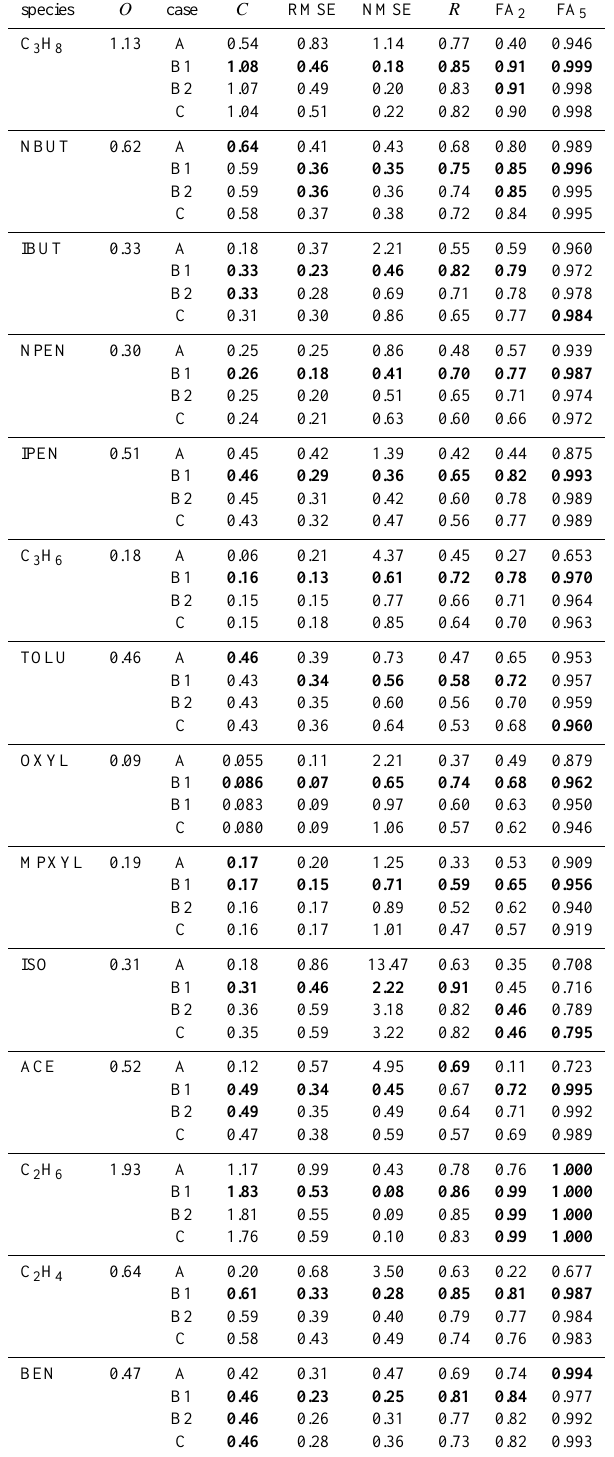
Table 6. Scores from the comparison between the observations and the simulated concentrations for four simulations. For each species, the first line represents the scores for the simulations with the background fluxes (case A). The scores of the second line and third lines are related to the simulations with the a posteriori emissions from Gaussian hyperparameters estimation (case B1 and case B2, respectively). The scores of the fourth line are related to the simulations performed with the a posteriori emissions under the truncated Gaussian assumption (case C). The means and the RMSE are in µgm − 3 . Bold numbers correspond to the best agreement with the